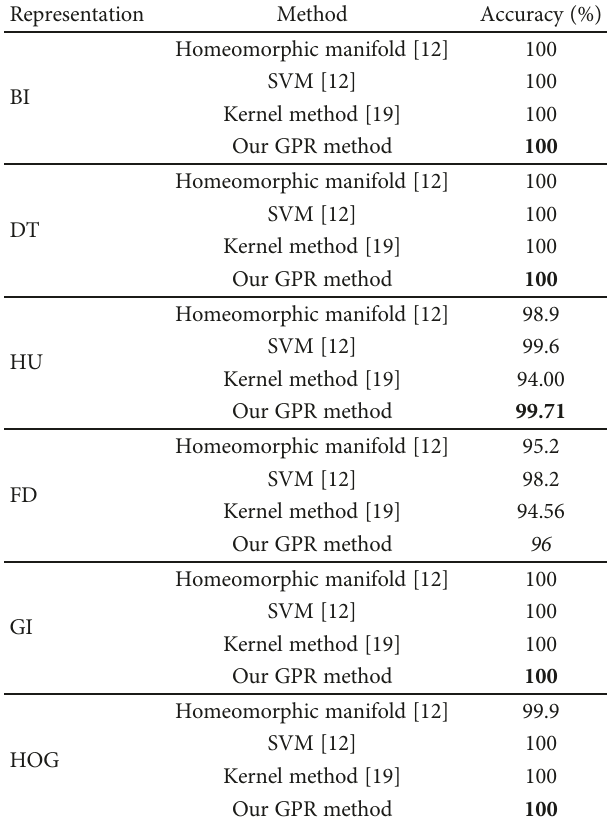
Table 3: Satellite recognition results on the 1D subset of BUAA-SID 1.5 and comparison with [12, 19]. Results are in bold if the proposed method performs the best and in italics if the second best.